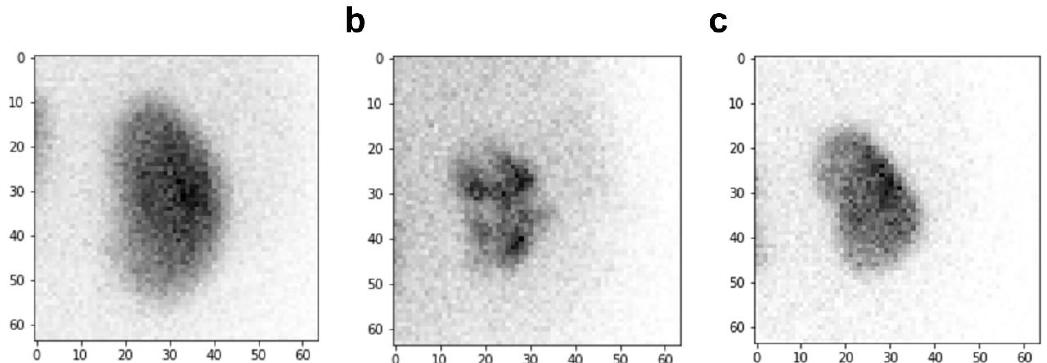
Figure 2. Representative cases of 99m Tc-DMSA renal scan. ( a ) A case without demonstrable abnormal-